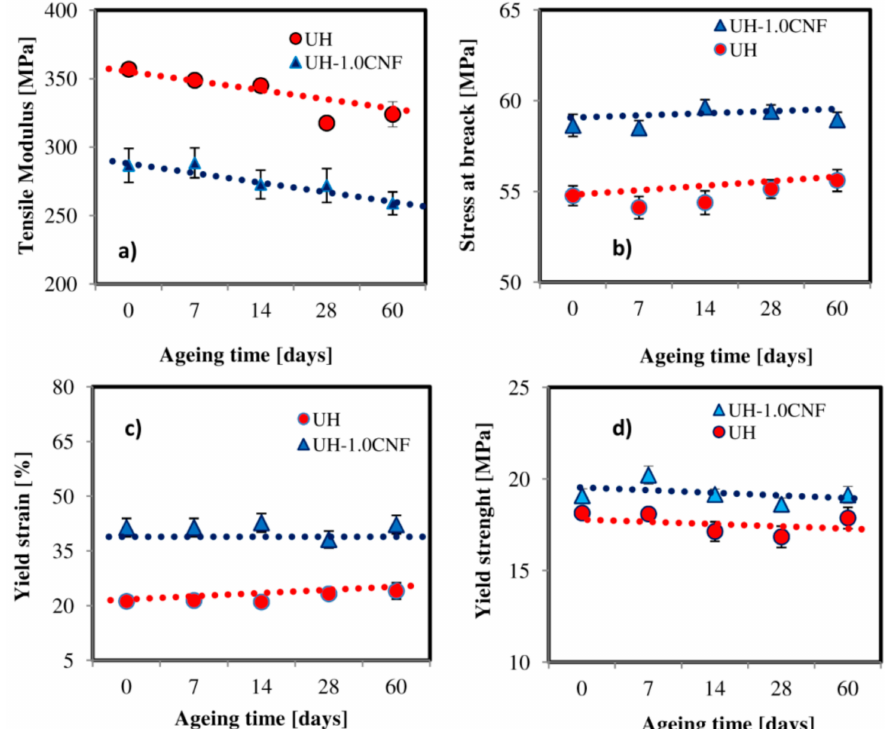
Figure 5. Tensile Modulus ( a ), Stress at break ( b ), Yield strain ( c ) and Yield strength ( a ) and strain at break ( b ) of UH and UH-1.0CNF samples during the 60 days of ageing